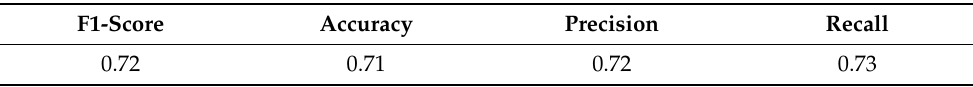
Table 3. Mazajak results.